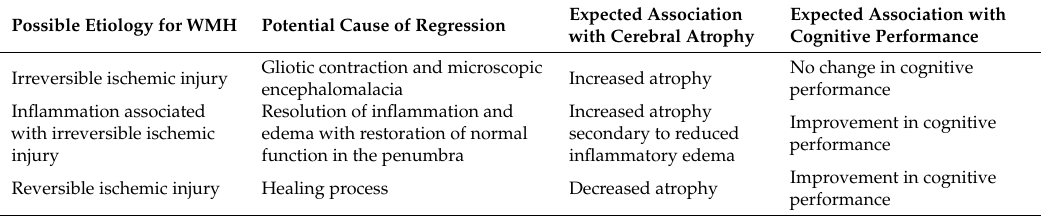
Table 1. Possible etiologies for cerebrovascular-related white matter hyperintensities that regress over time and the expected associations with cerebral atrophy and cognitive performance. Possible Etiology for WMH Potential Cause of